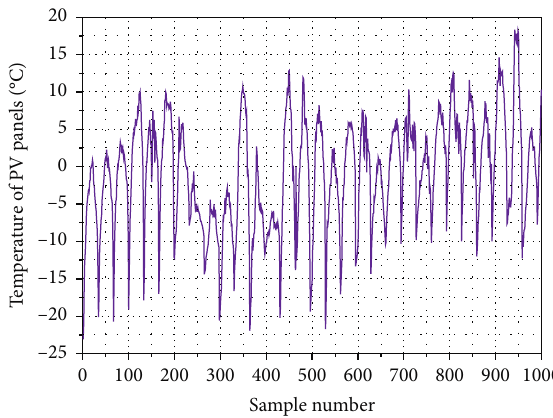
Figure 3: The recorded temperature data of PV